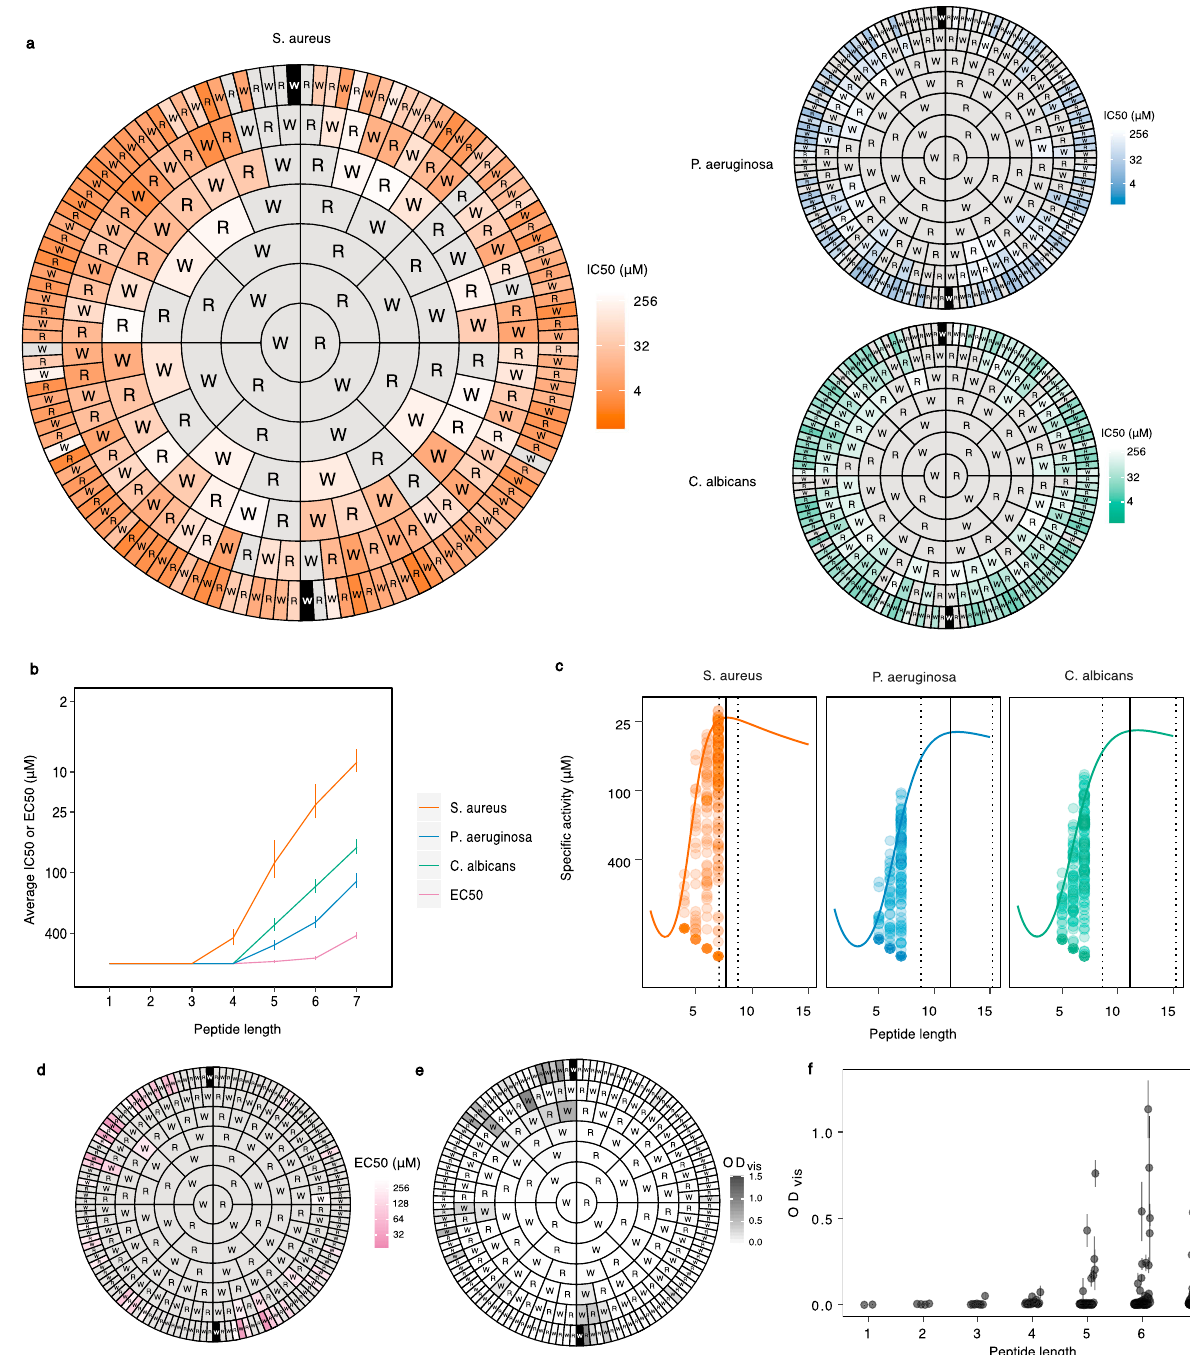
Fig. 1 Antimicrobial activity for the complete set of peptides comprised of W and R up to 7 residues long. a Activities are represented for peptide sequences arranged using a concentric ring chart system (referred to as ‘ Harris-Clark diagrams ’ ). Each peptide can be identi fi ed by reading the sequence from the N-terminal residue in each ring towards the C-terminal residue at the centre of the chart; inhibitory activity (IC 50 ) is indicated for that peptide by the colour of shading in the outermost compartment (i.e. the compartment identifying the N-terminal of each peptide). The three separate Harris-Clark diagrams show the inhibitory activities against S. aureus , P. aeruginosa and C. albicans . Grey sections represent peptides which did not exhibit an IC 50 within the range of concentrations assayed (0.8 – 400 µ M). The two peptides which could not be synthesised are indicated by black sections with white lettering. Similar plots for MBC are shown in Supplementary Fig. 1. b Effect of peptide length on harmonic means and standard deviations for IC 50 and EC 50 . Similar plots for MBC are shown in Supplementary Fig. 1. All error bars shown are ±s.d. ( n = 2, 4, 8, 16, 32, 64 and 126 peptides for lengths 1 – 7, respectively) c Speci fi c activities of each peptide plotted against length. Quantile regressions (90% quantile), represented by coloured lines, show the trend of speci fi c activity with length. The solid vertical lines indicate the predicted peptide length with the greatest speci fi c activity, and the dotted lines indicate the 95% credibility interval for this prediction generated by sampling from the posterior distribution of a Bayesian model (see Methods). The distribution of haemolytic activity for individual peptides is shown in ( d ) and of turbidity of 800 µ M stock solutions (OD vis ) in ( e ), whereas ( f ) shows OD vis of the same stock solutions plotted against peptide length.